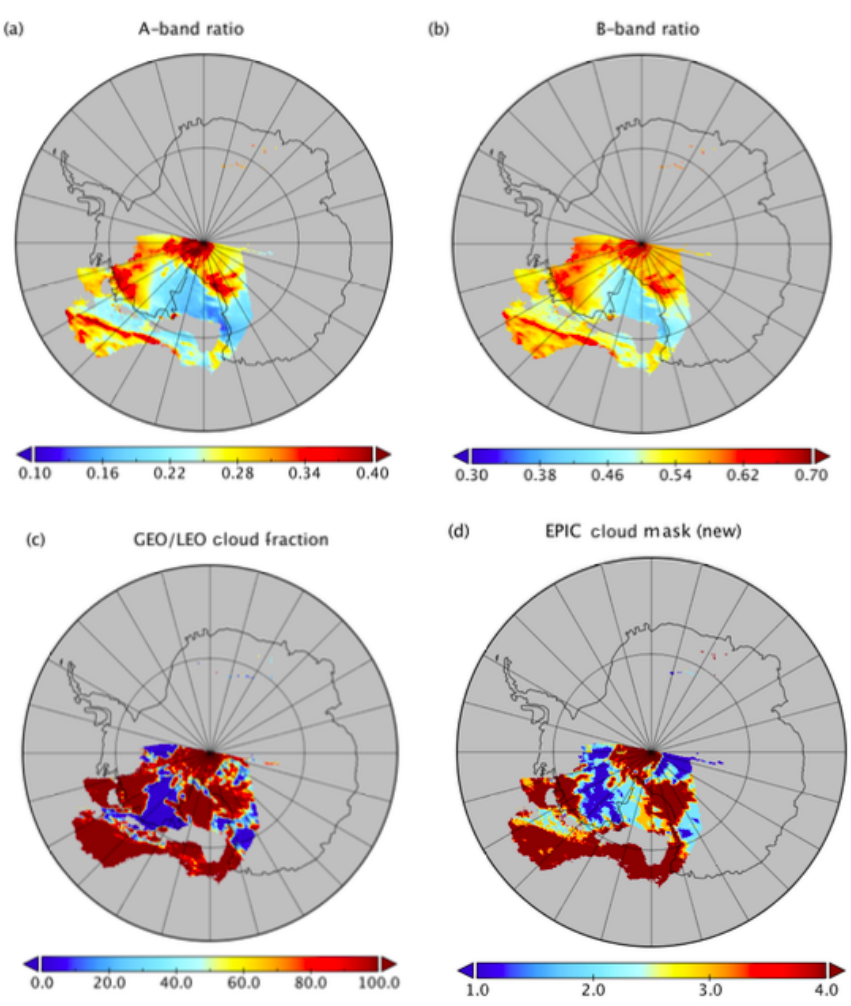
Figure 6. Section of an EPIC granule on 23 December 2017, 17:07UTC time, with matching GEO/LEO overpass within 5min of the EPIC scan over western Antarctica. (a) A-band ratio, (b) B-band ratio, (c) cloud fraction from the GEO/LEO composite, and (d) cloud mask from the new